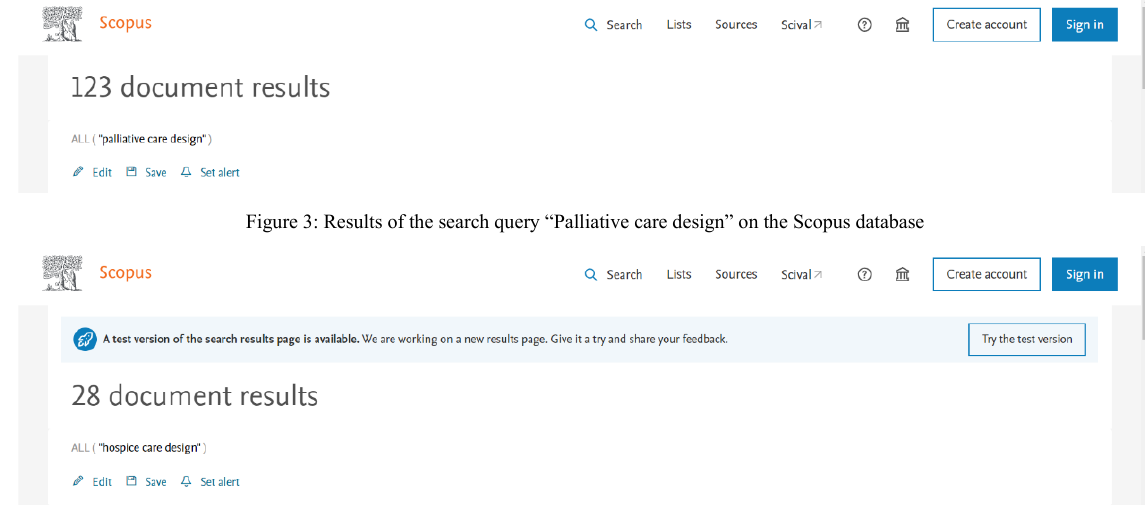
Figure 4: Results of the search query “hospice care design” on the Scopus